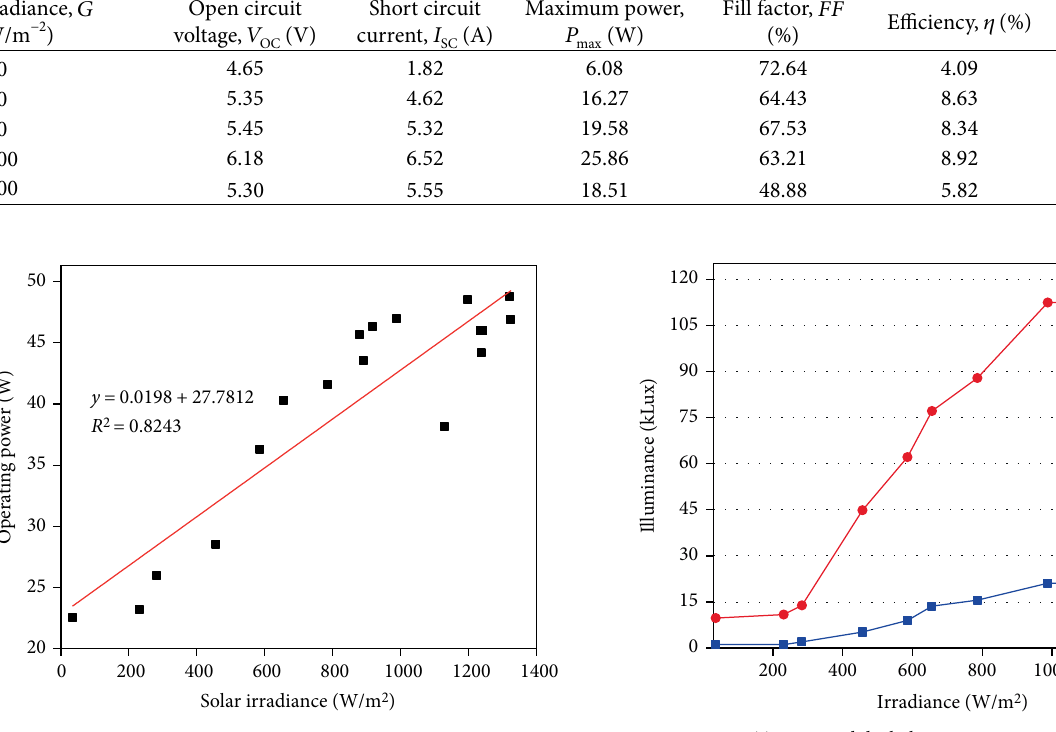
Figure 8: Correlation between power generated and solar irradiance.